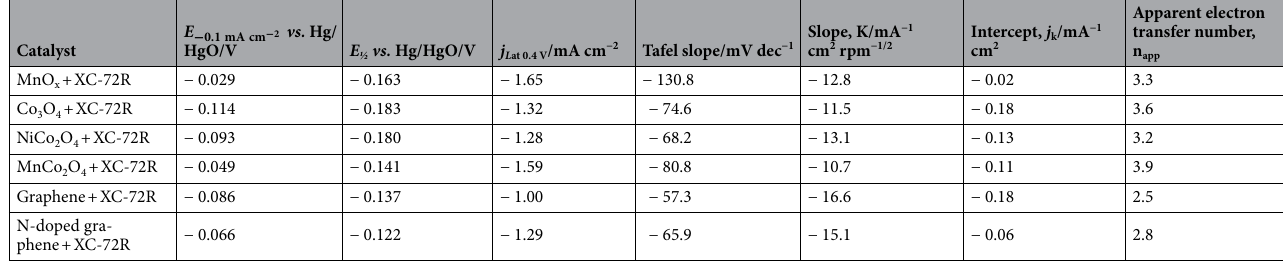
Table 3. ORR kinetic parameters from LSV, Tafel and K-L plots of catalysts combined with